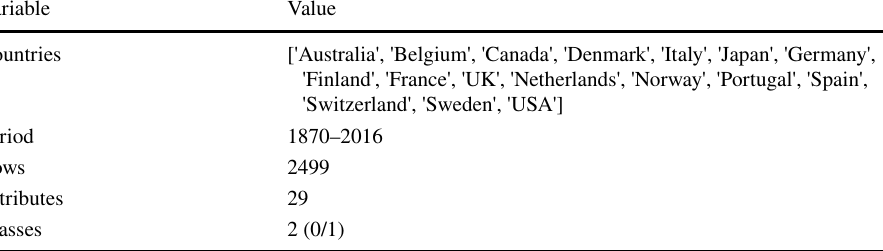
Table 2 The description of the